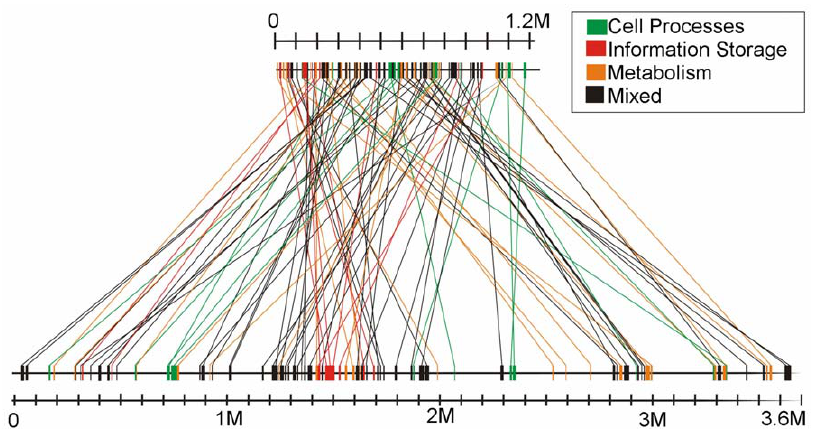
Figure 1. Comparative organization of the circular chromosomes of ‘ Ca. Liberibacter asiaticus’ and S. meliloti . Microsyntenous orthologous genes (MOGs) were identified and plotted on respective chromosomes. Lines connect identical blocks of genes. The upper chromosome is that of ‘ Ca. Liberibacter asiaticus’, 1.2 Mb. The bottom chromosome is that of chromosome of Sinorhizobium meliloti (3.7 Mb).